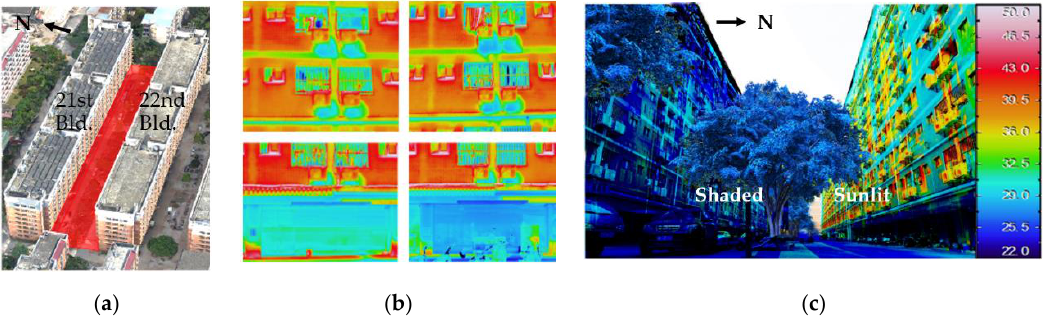
Figure 5. 3D models and thermal images around the dormitory buildings. ( a ) 3D model; ( b ) thermal images taken at 14:00, 20 September 2018; ( c ) 3D thermography jointed from 168 pieces of thermal images.